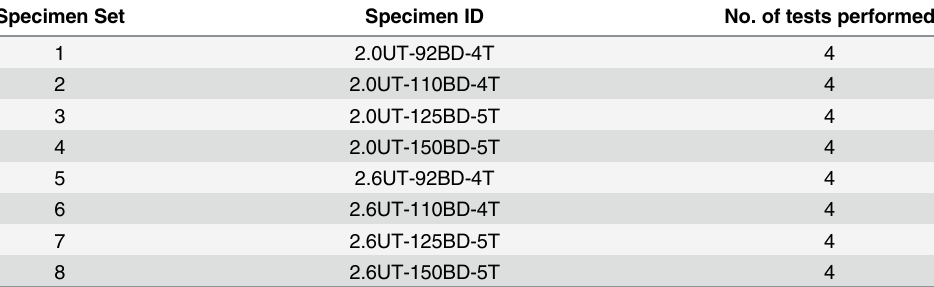
Table 4. Details of specimens ’ ID.